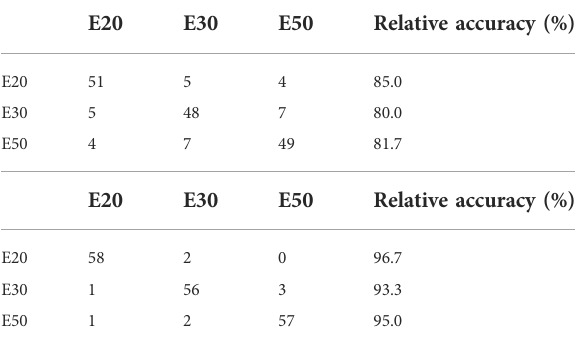
TABLE 1 Confusion matrix for stiffness discrimination. (A) stiffness without texture. (B) stiffness with